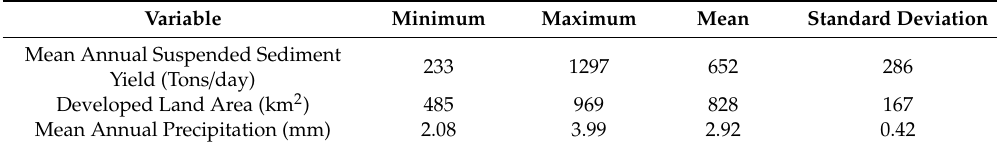
Table 2. Summary statistics of the Multiple Linear Regression (MLR)